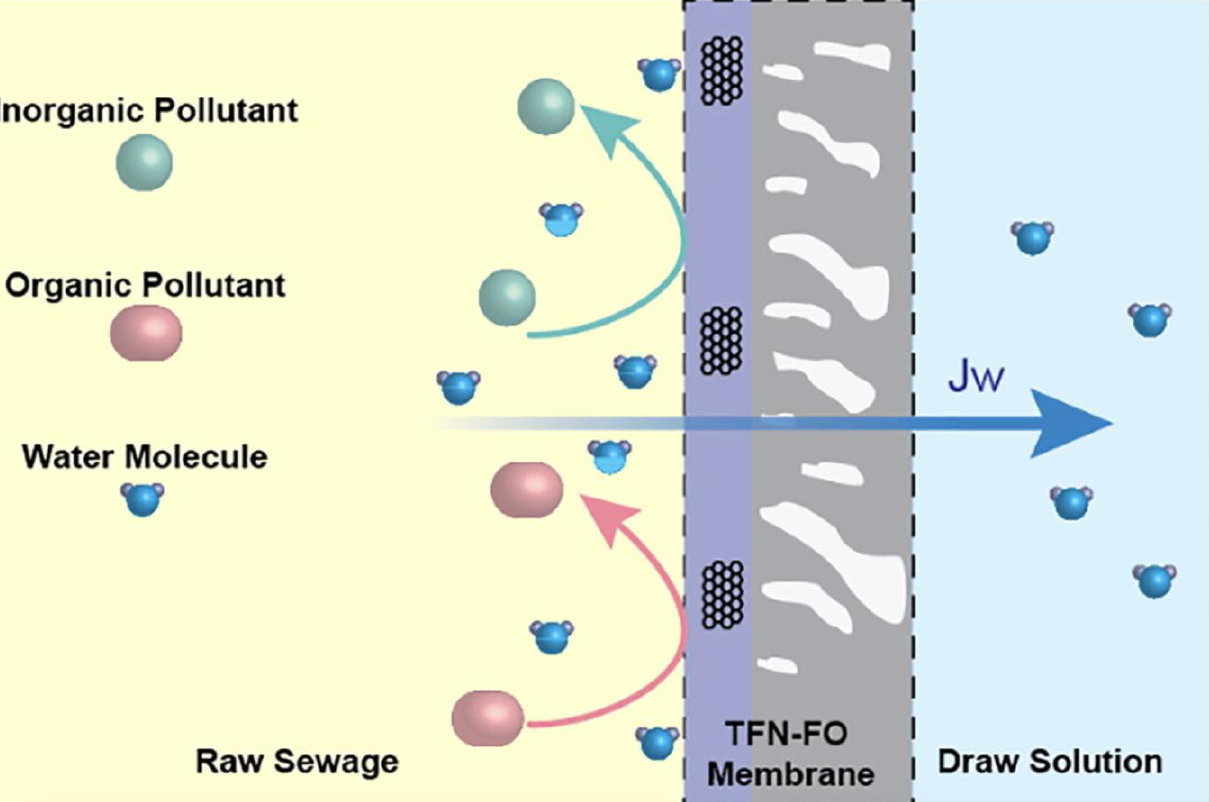
Figure 5. Schematic of forward osmosis (FO) principle (reprinted with permission from Ref. [133] Wu et al., 2021).